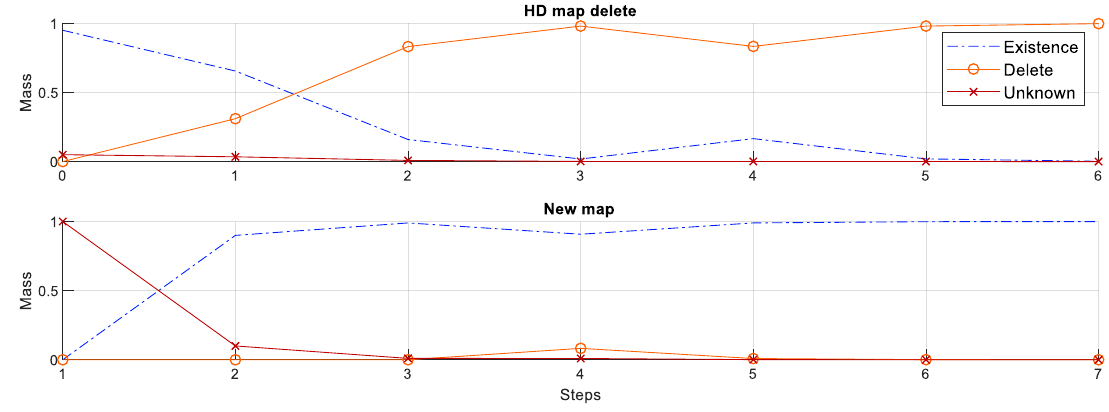
Figure 8. Mass functions of existence state for the deletion of HD map feature and the creation of new map